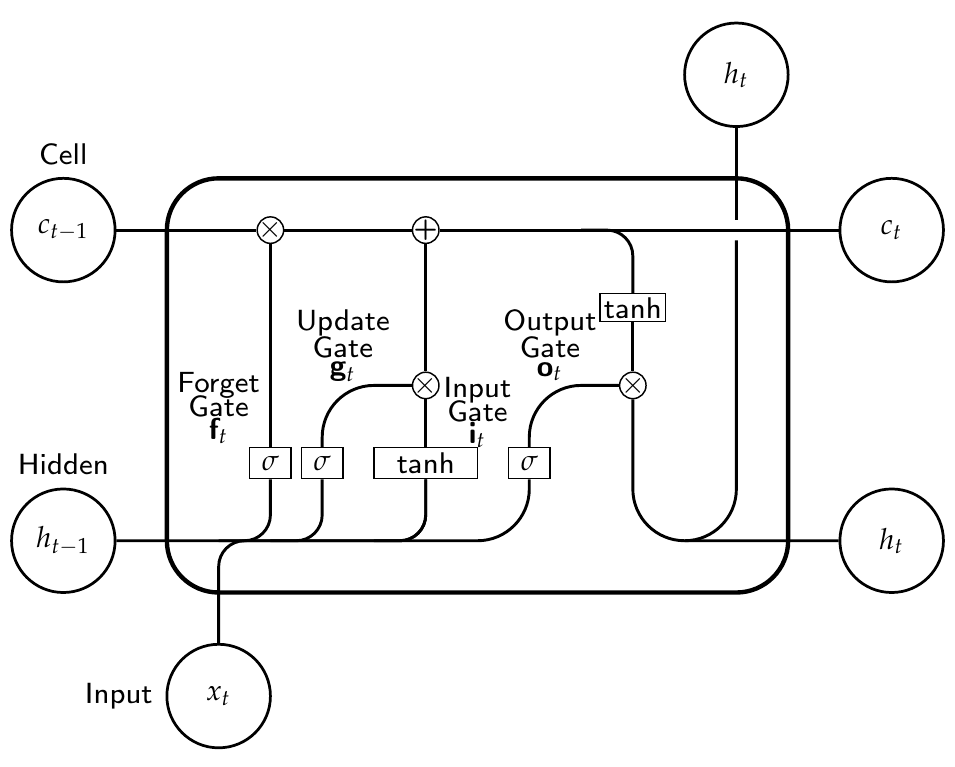
Figure 1. Schematic of a LSTM memory cell